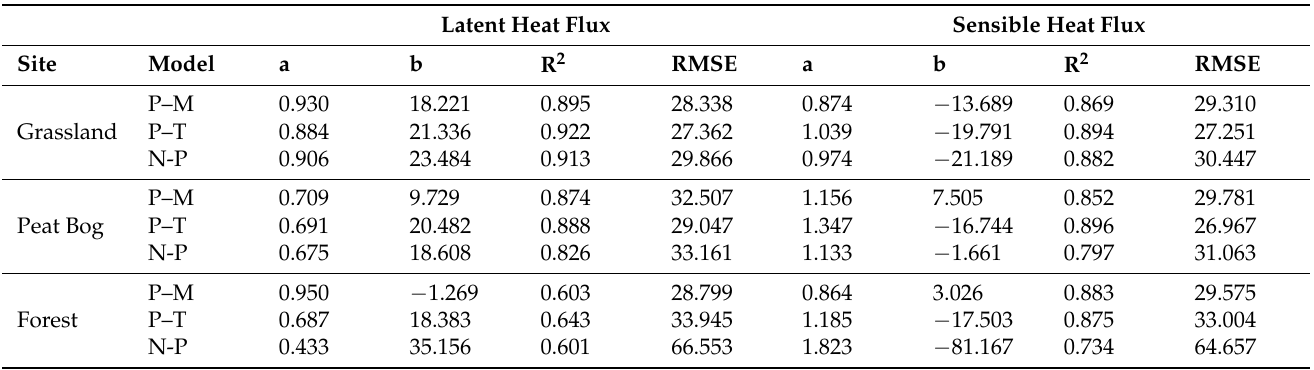
Table 3. Summary of regression analysis between measured and model-predicted fluxes at the three sites. Y = aX + b; Y is measured flux; X is predicted flux.